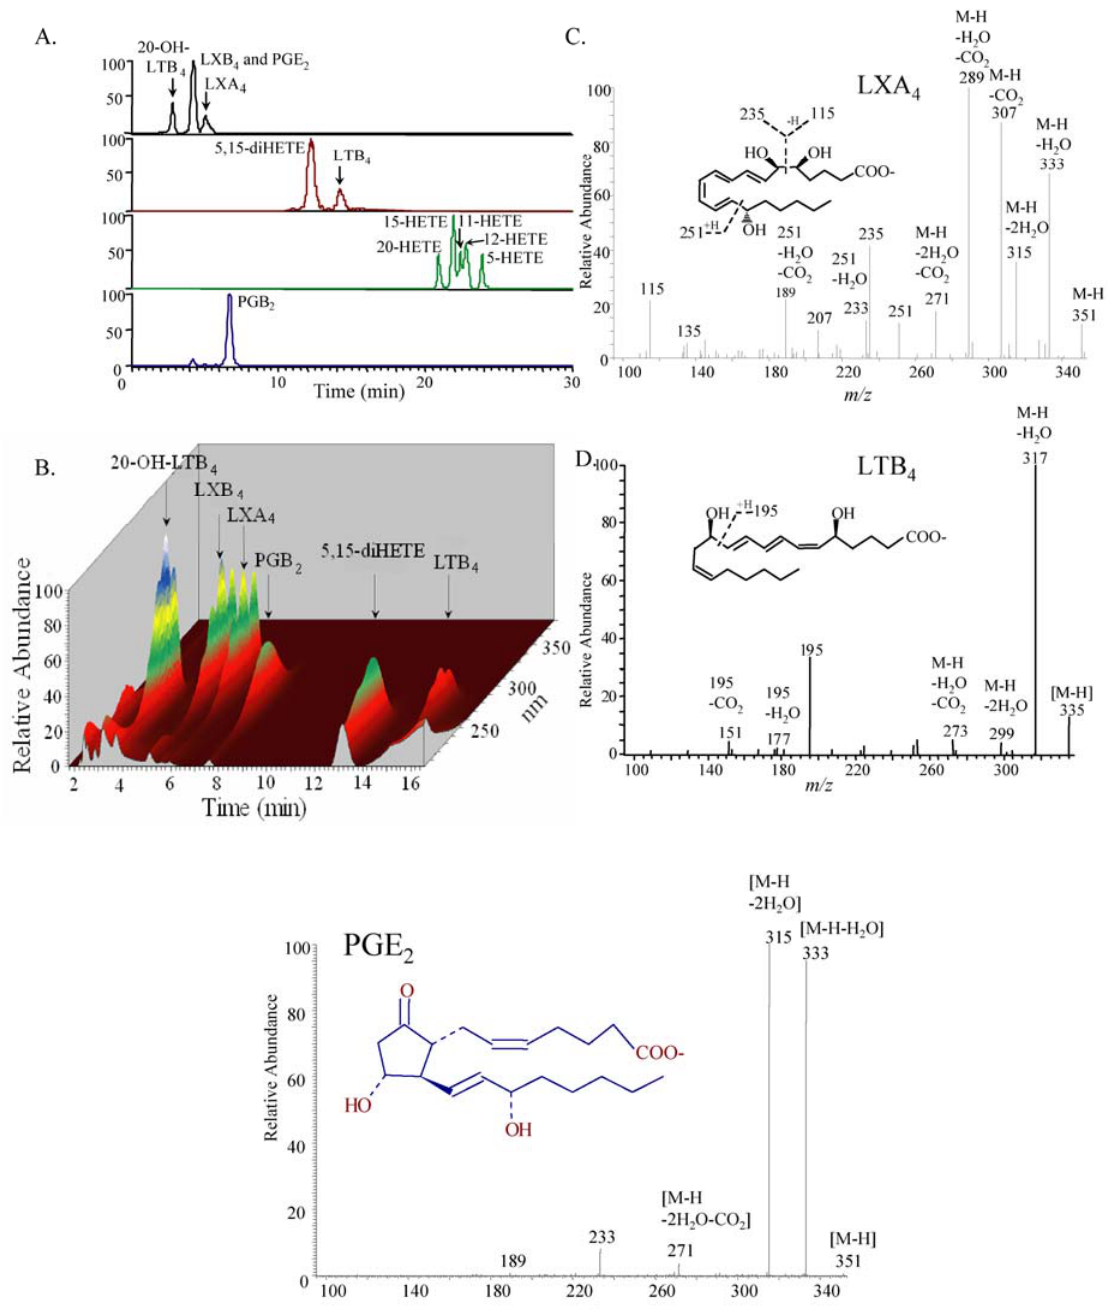
FIGURE 2. LC-UV-MS/MS-based lipidomics for eicosanoids biosynthesized via LOX and COX pathways. Analysis was conducted using LC-UV-MS/MS. (A) SIM chromatograms showing triHETEs and PGE2 (m/z 351), diHETEs (m/z 335), and HETEs (m/z 319). (B) The 3-dimensional display of LC-UV spectra and chromatograms showing maximal absorbance at 300 nm for LXA 4 and LXB 4 , at 270 nm for 20-hydroxy-LTB 4 and LTB 4 , and at 240 nm for 5,15-diHETE. (C) MS/MS spectrum (m/z 351) for LXA 4 . (D) MS/MS spectrum (m/z 335) for LTB 4 . (E) MS/MS spectrum (m/z 351) for PGE 2